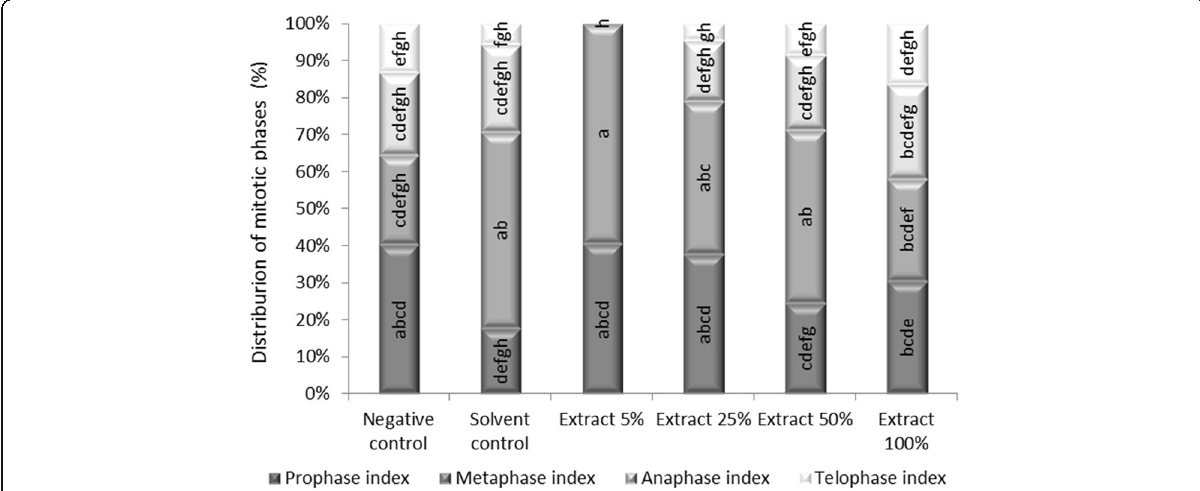
Fig. 5 The influence of the juniper extract on the distribution of the mitotic phases in the root cells of Allium cepa L. (a – h: interpretation of the significance of the differences, by means of the Duncan test, p <